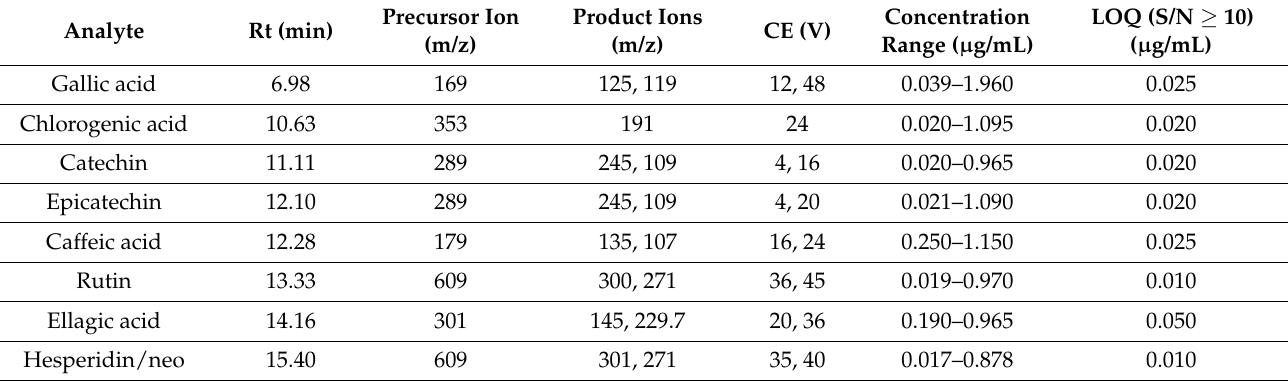
Table 6. Data for analytes identification and quantification using LC-MS/MS